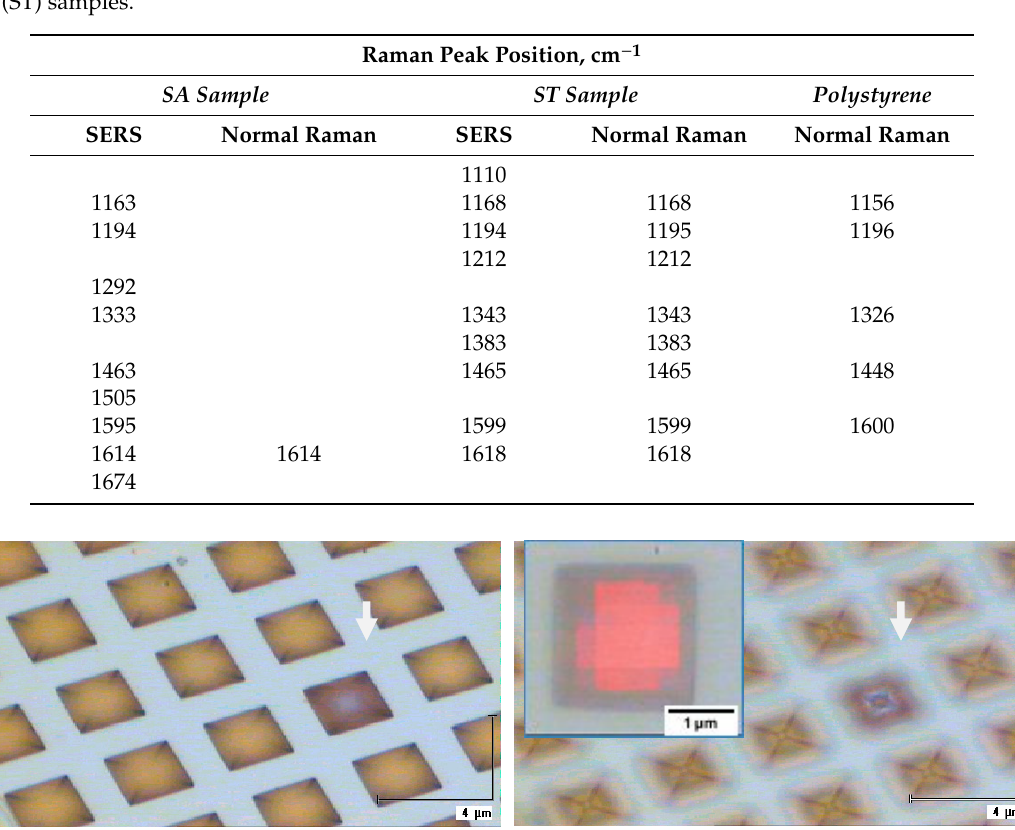
Table 2. Peak positions in normal Raman and SERS spectra of Sigma Aldrich (SA) and Spherotech (ST) samples.